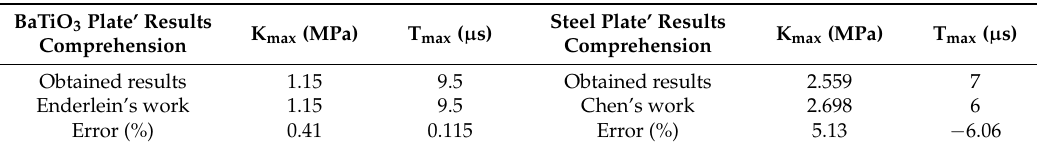
Table 1. Comparison of the results (present results and previous works [22,24–26]) for the investigated case studies.